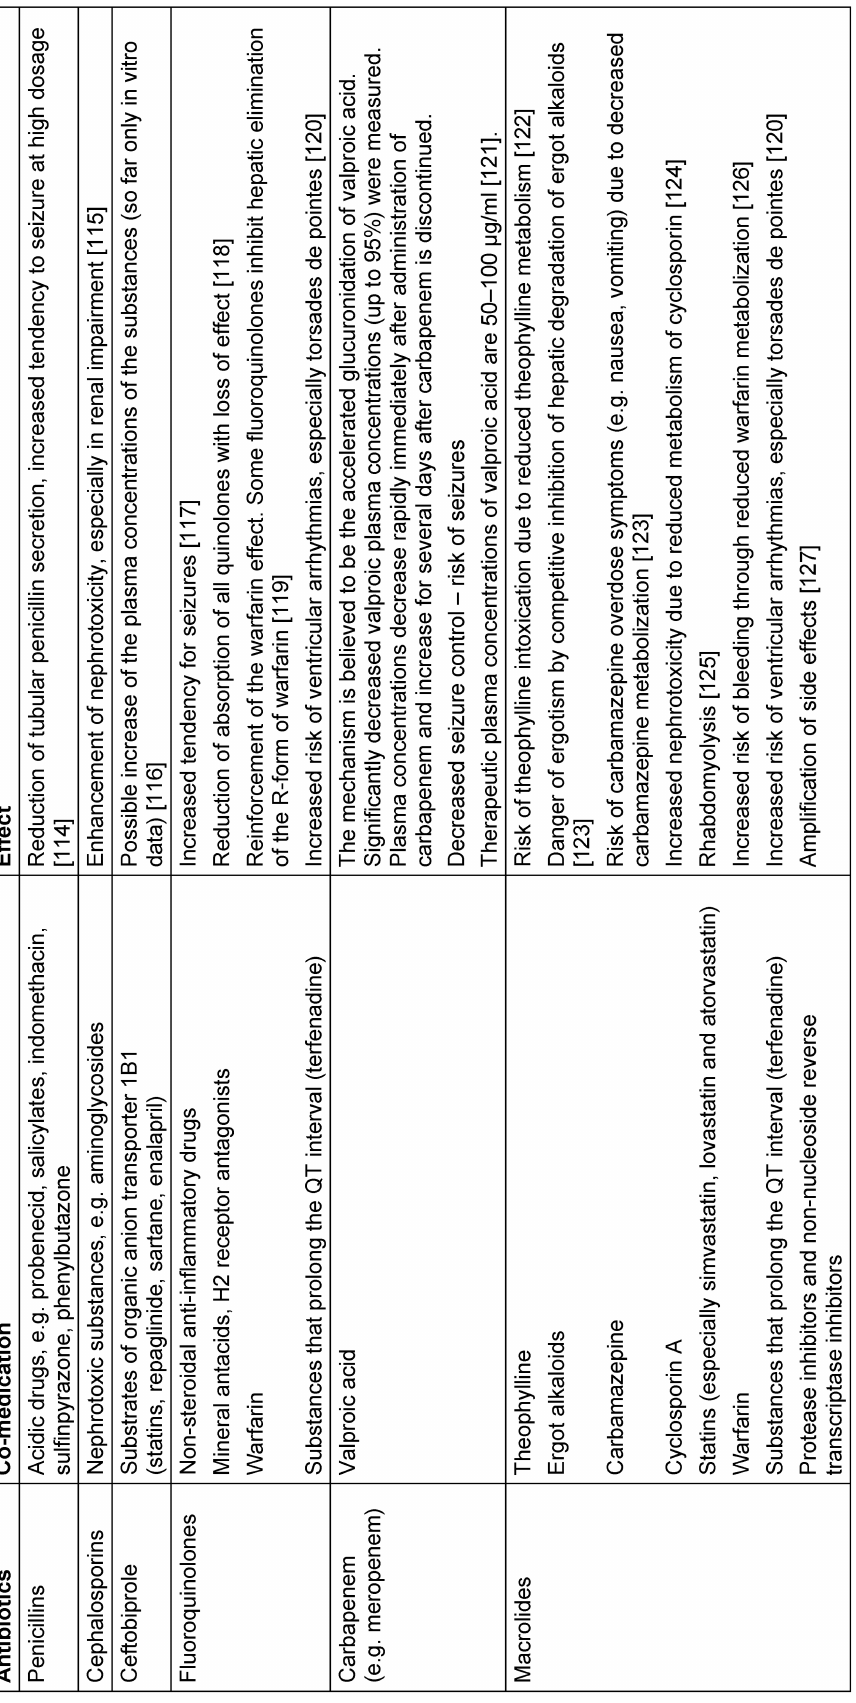
Table 6: Interactions of antibiotics with other medicines and their